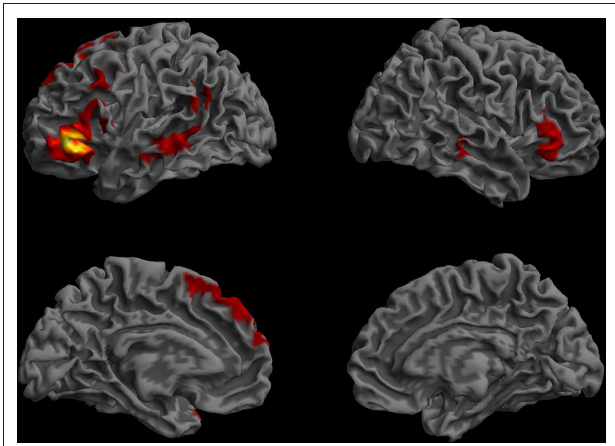
Figure 9 | resting-state functional connectivity map of the BA 47 region of interest. (Lateral and medial views of the left and right hemispheres, p < 0.01, corrected, cluster extent > 100 mm 3 , colors indicate t -values, dark red = lowest, yellow-white = highest, with the voxels within the ROI showing the highest